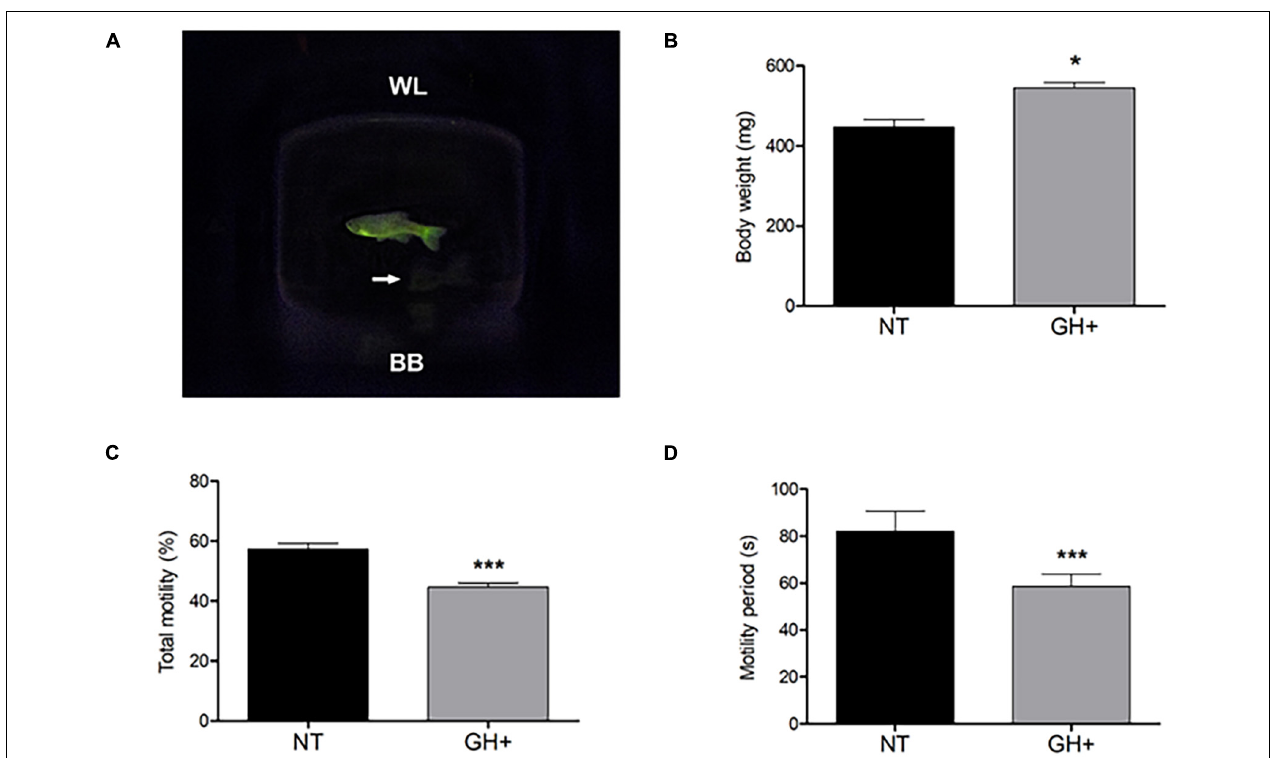
FIGURE 1 | Indications of transgenic phenotype in a photographic image of male zebrafish, changes in body weight, and sperm kinetic parameters of gh -transgenic F0104 strain zebrafish ( Danio rerio ) and non-transgenic strain. (A) gh -transgenic zebrafish male from F0104 strain showing the ubiquitous and constitutive distribution of GFP expression; non-transgenic zebrafish shown in white arrows; (B) bodyweight characteristics; (C) total motile sperm; (D) sperm motility period. All p -values < 0.05 are summarized with one asterisk and < 0.0001 with three asterisks. Results are statistically expressed by mean ± standard error of the mean (SEM) ( n = 10 for each experimental group). NT, non-transgenic; GH+, gh -transgenic; WL, water line; BB, bottom of